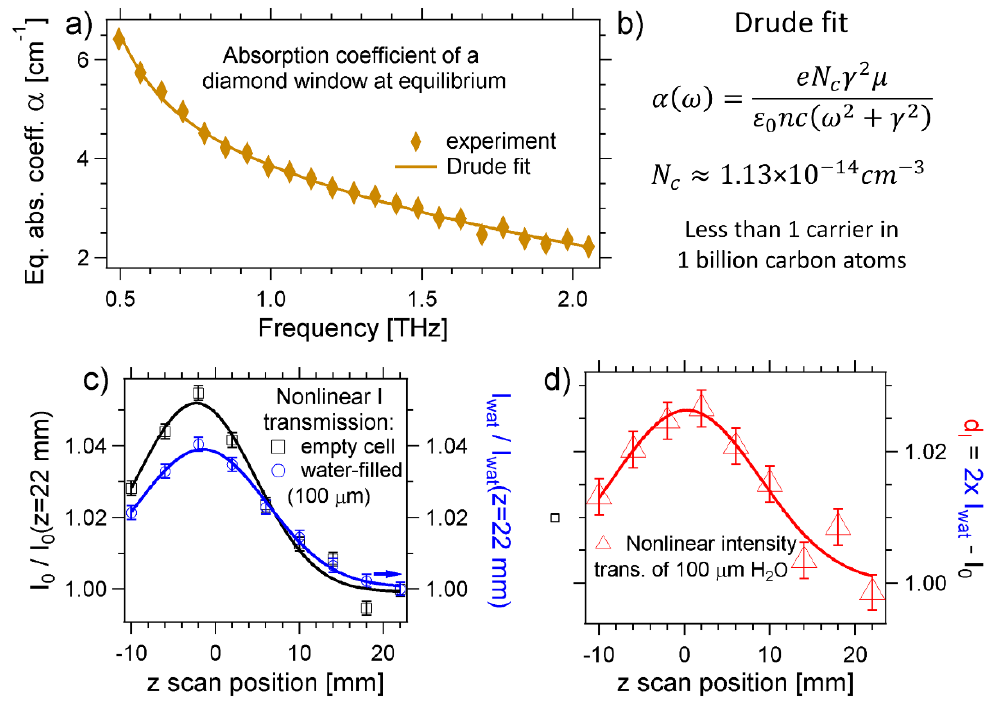
Figure 2. ( a ) Absorption coe ffi cient of a single diamond window of the empty sample holder measured with linear THz time-domain spectroscopy. ( b ) The absorption can be fitted to a Drude peak with few free carriers, corresponding to less than one carrier per billion carbons. ( c ) Z scan measurements of the THz intensity transmitted by the empty diamond cell (black), and of the liquid cell filled with a 100-micron thick water layer (blue). The error bars are the standard error of the mean calculated from 300 measurements. The squares and circles are the experimental results, the solid lines are guides to the eye. ( d ) The nonlinear intensity transmission of the water layer is estimated as the di ff erence of the intensity transmissions of filled and empty cell (d I ). The solid red line is a Gaussian fit. The experiments reported in Panels c–d are performed with an intensity detector